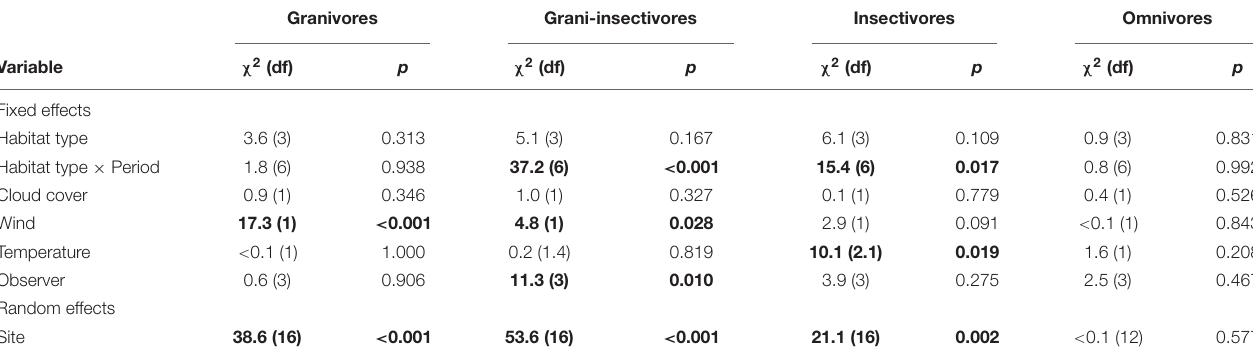
Granivores Grani-insectivores Insectivores